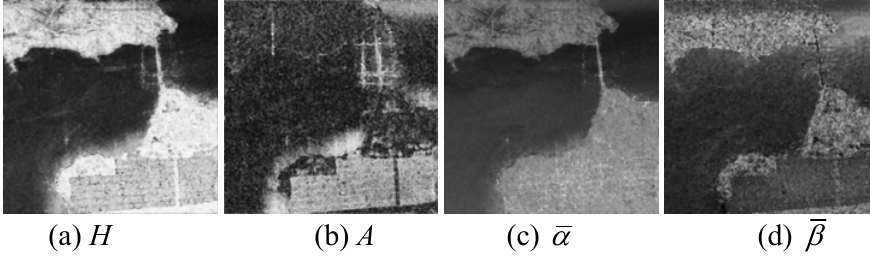
Figure 6. Parameters of H/A/Alpha